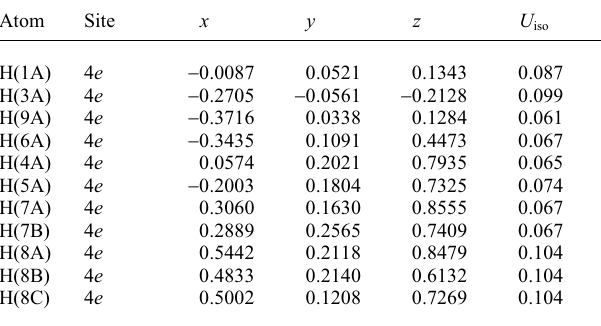
Table 2. Atomic coordinates and displacement parameters (in Å 2 )